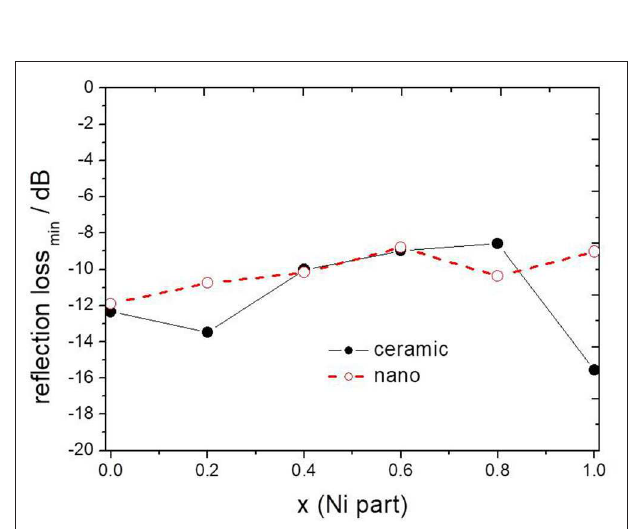
FIGURE 9 | The reflection loss of epoxy composite containing ceramic and nanoparticles of Ni 0.8 Zn 0.2 Fe 2 O 4 ferrites. FIGURE 11 | The maximum value of attenuation depending on x (Ni content) in composite containing ceramic and nanoparticles of Ni x Zn (1 − x) Fe 2 O 4